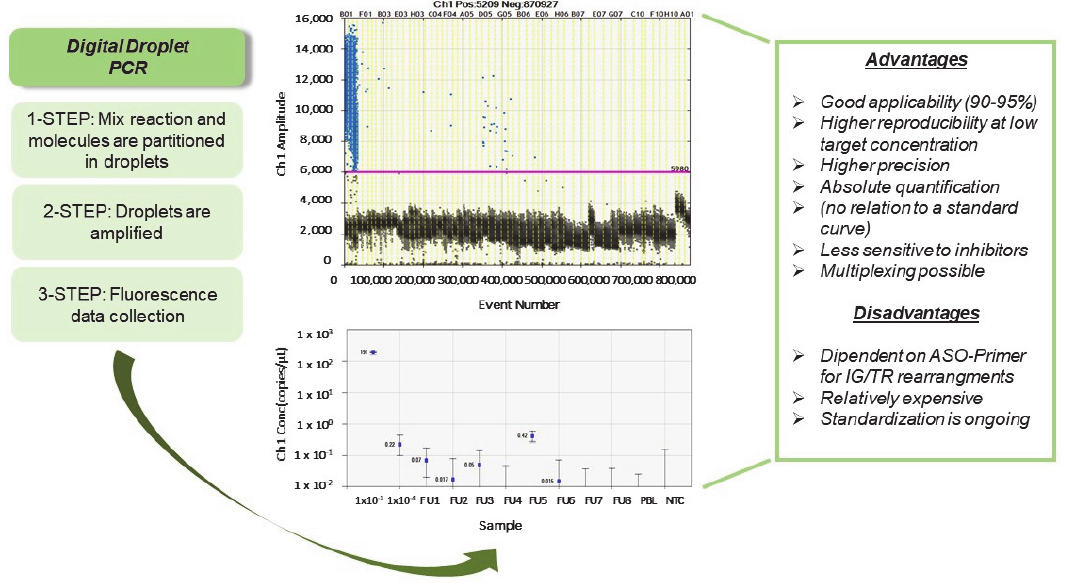
Figure 1. ddPCR technology. This figure reports an analytical diagram for a ddPCR experiment. The mix reaction and the DNA samples are partitioned into 20,000 droplets ( 1-step ), and then both are amplified in a thermal cycler ( 2-step ). Finally, each droplet is individually analyzed by a droplet reader ( 3-step ). Each droplet is plotted on the graph of fluorescence intensity, and the concentration is calculated on the fraction of droplets that does not contain any target DNA using software. The positive droplets are fitted to a Poisson algorithm to determine absolute copy number expressed as copies per 1 μ L.